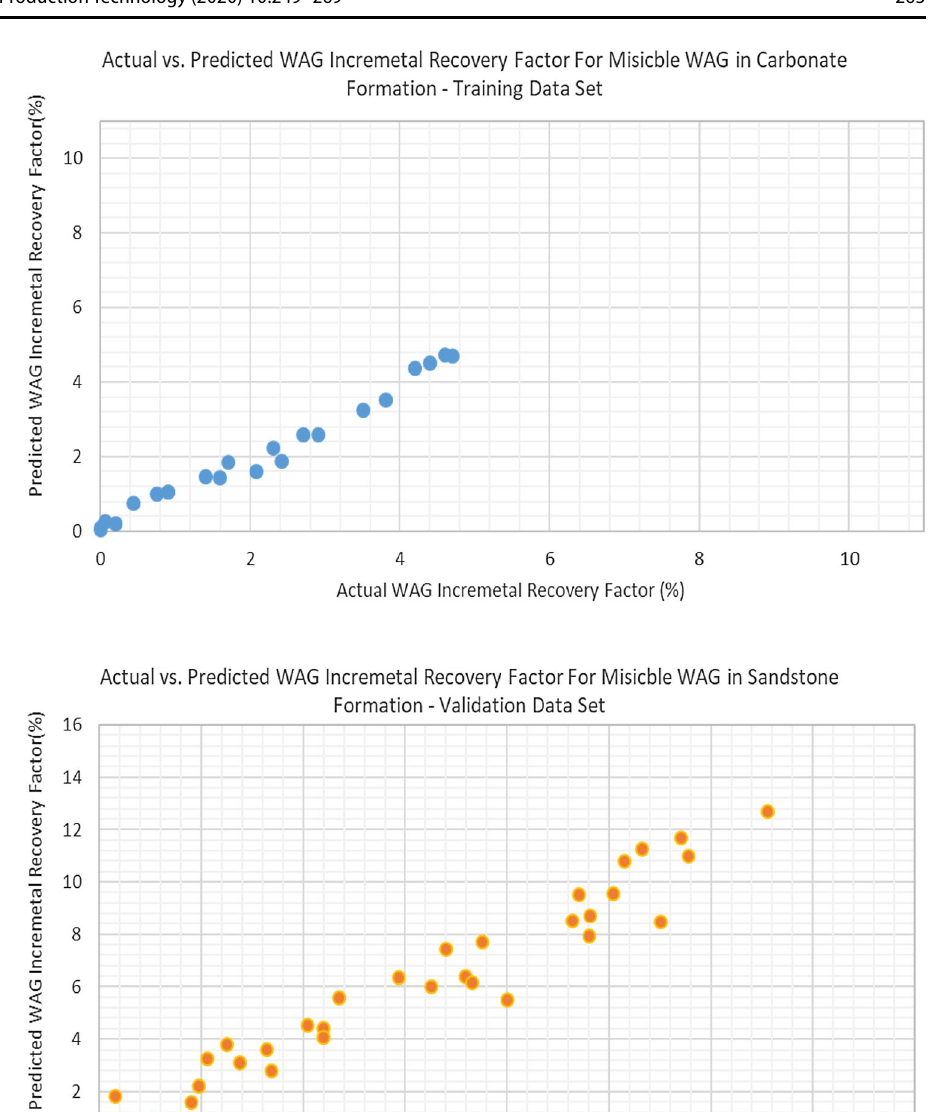
Fig. 16 GMDH WAG incre- mental recovery factor predic- tion model training results for